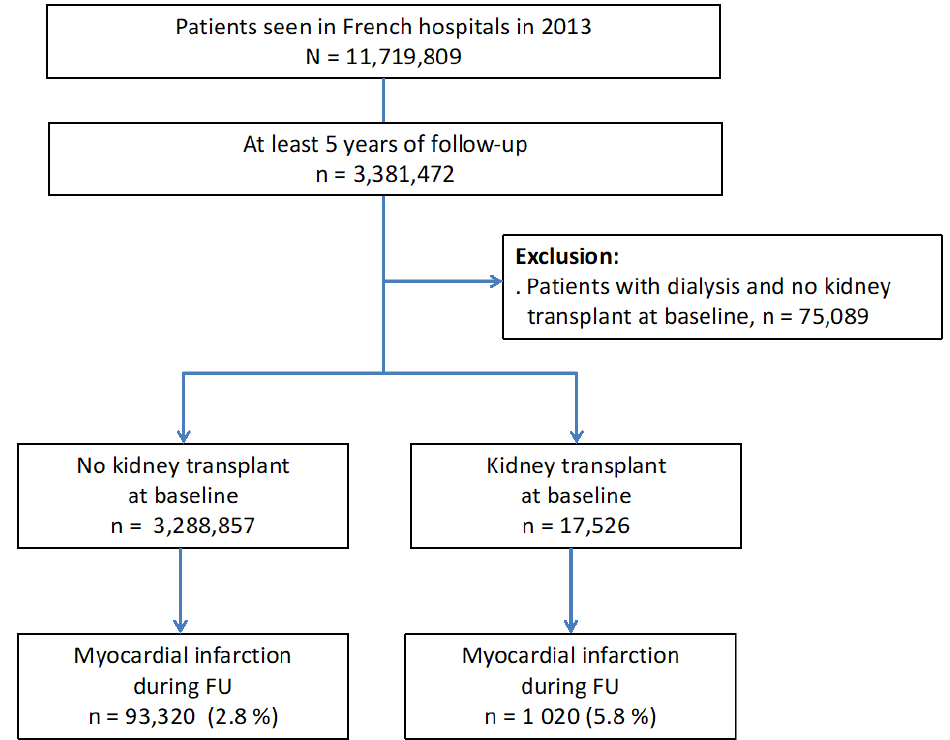
Figure 1. Flow chart of the study describing the incidence of MI in patients with kidney transplant or no kidney transplant seen in French hospitals in 2013 with at least five years of follow-up. (FU = Follow